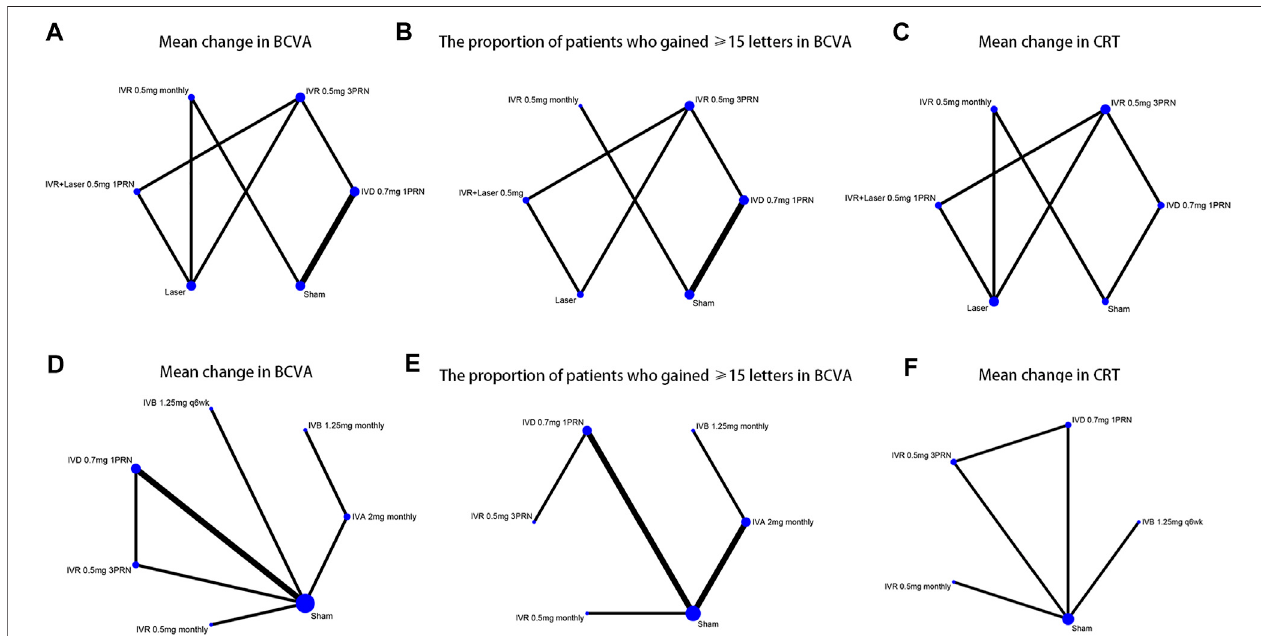
FIGURE 1 | Network ofthe comparisons for the Bayesian network meta-analysis (A – C) The ef fi cacy outcomes of macular edema secondary tobranch retinal vein occlusion (D – F) The ef fi cacy outcomes of macular edema secondary to central retinal vein occlusion.